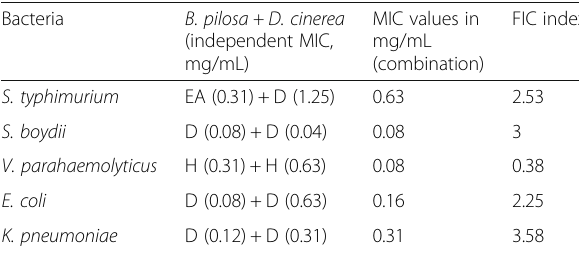
Table 4 MIC values of synergistic activity for B. pilosa and D. cinerea leaf extracts